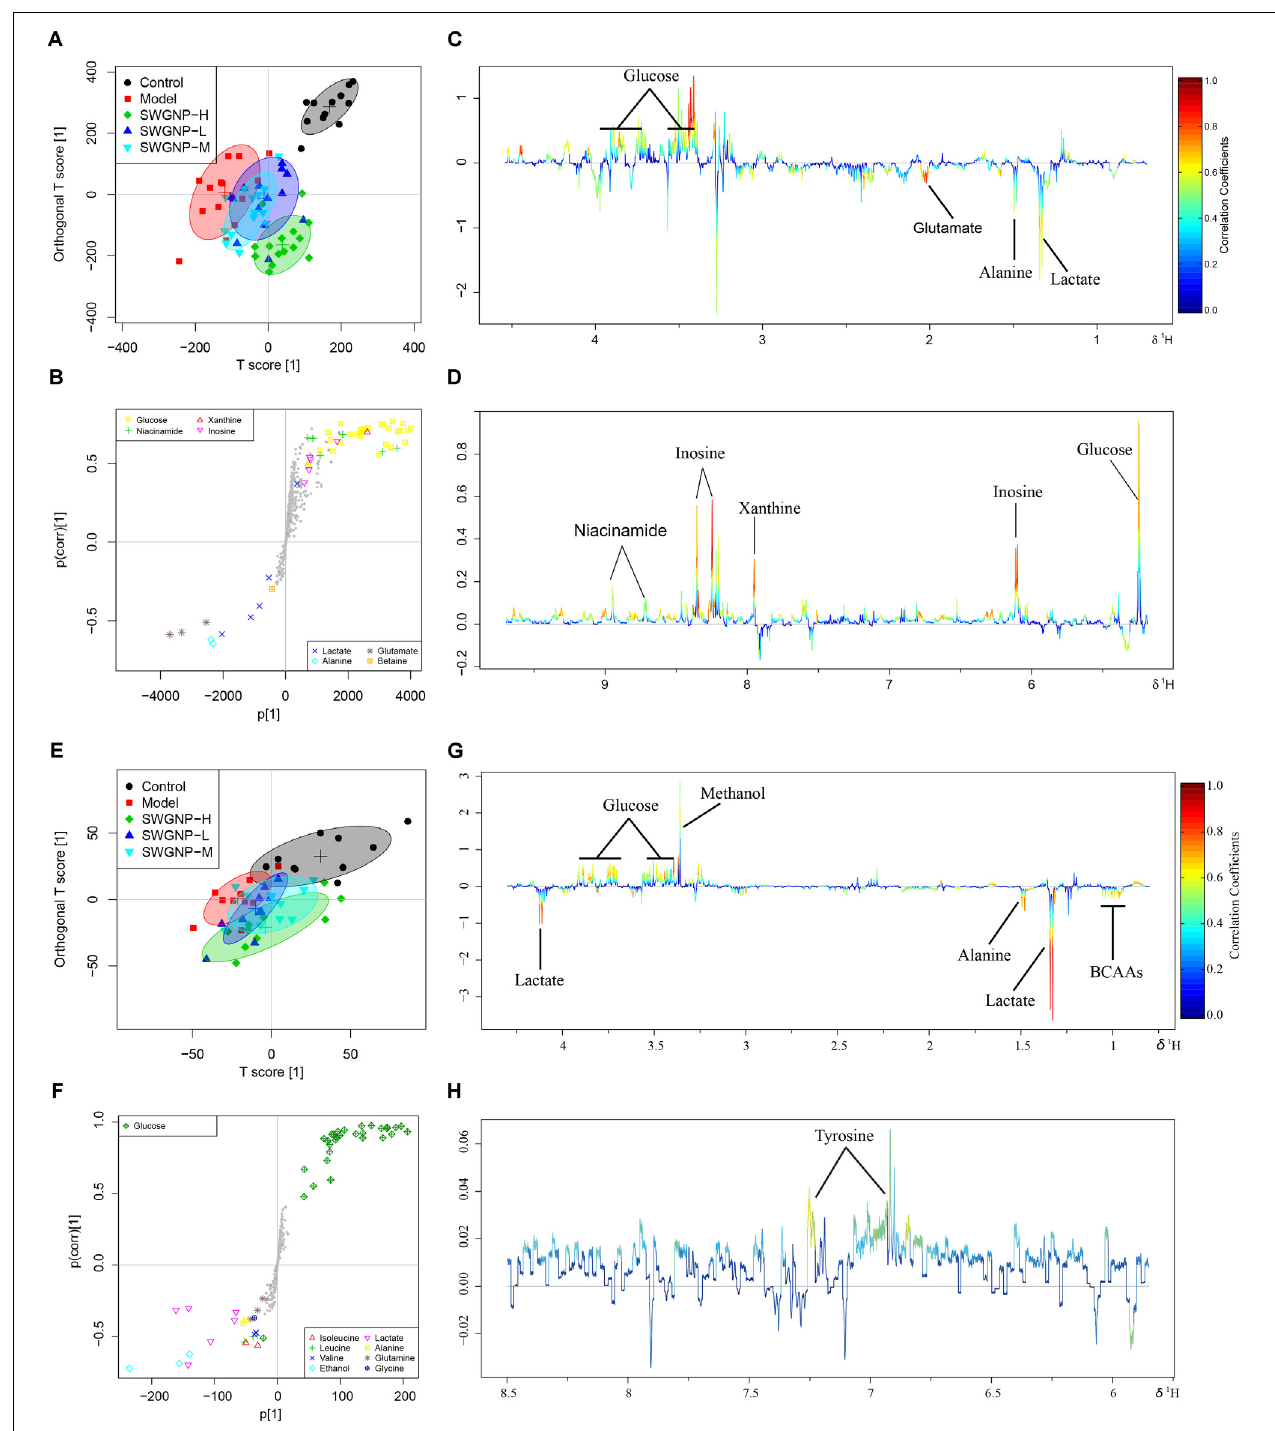
FIGURE 6 | Multivariate analysis of 1 H NMR data of liver (A–D) and serum (E–H) extracts for control, model, and low, medium, and high dose of SWGNP treated rats. Score plots (A,E) and corresponding S-/loadings plot (B–D,F–H) for OPLS-DA, color-coded with the absolute value of correlation coefficients.